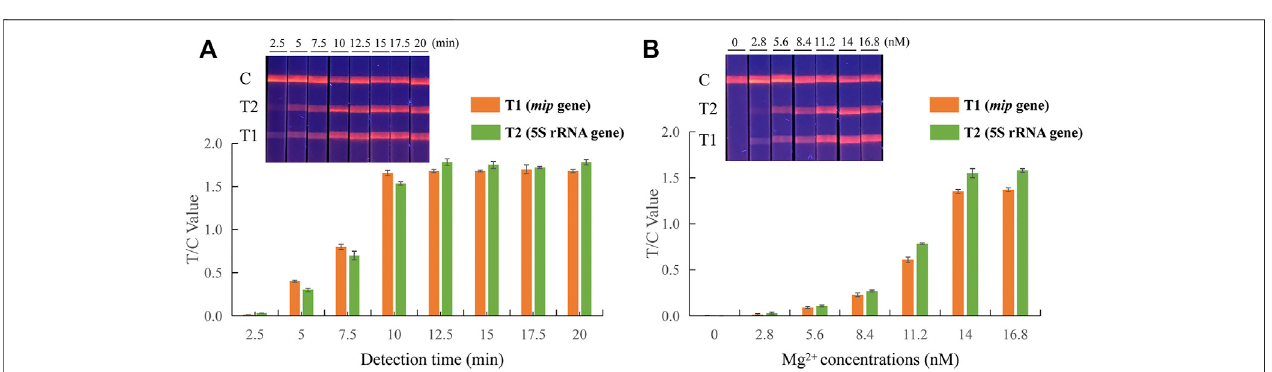
FIGURE 2 | Parameter optimization of dual EuNPs-LFIC-RPA assay. (A) incubation time; (B) the concentration of magnesium ions.